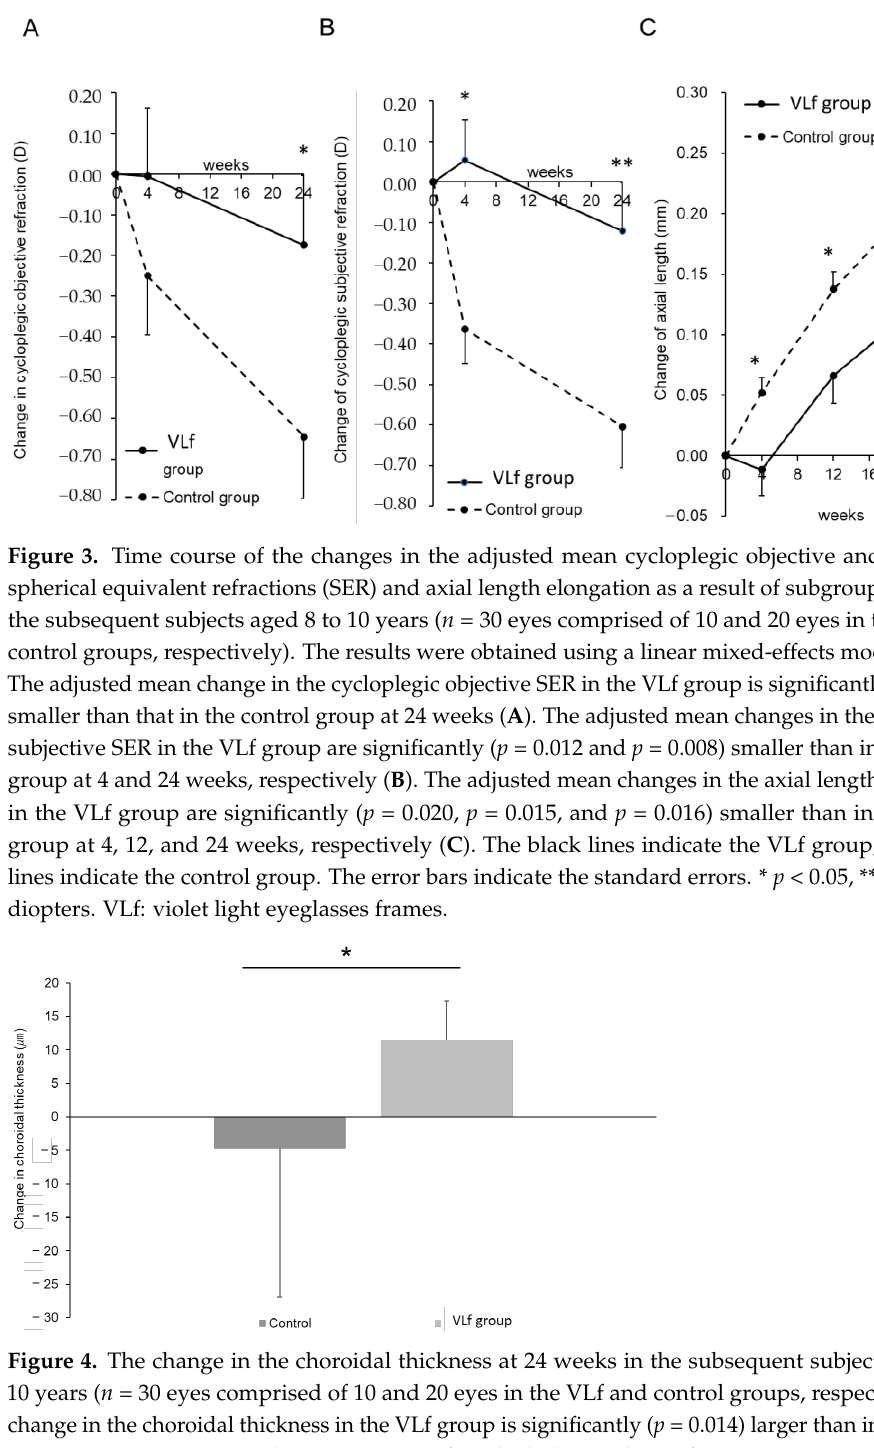
Figure 4. The change in the choroidal thickness at 24 weeks in the subsequent subjects aged 8 to 10 years ( n = 30 eyes comprised of 10 and 20 eyes in the VLf and control groups, respectively). The